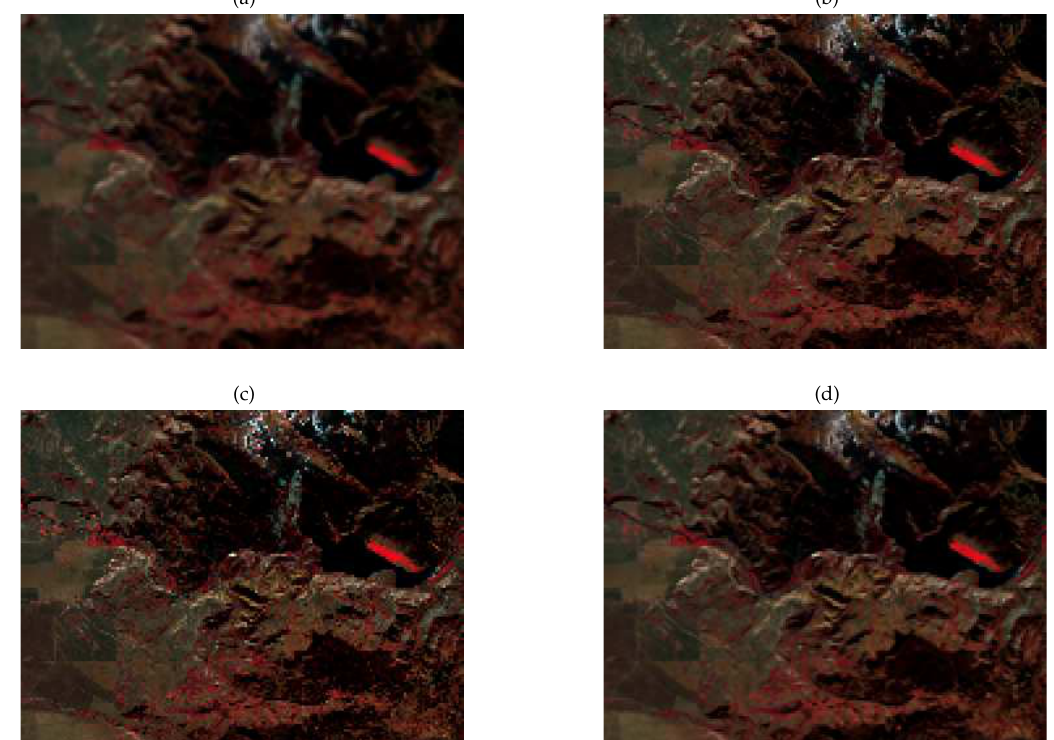
Figure 8. Simulated images filtered by: ( a ) Gaussian MTF with K m = 0.1; ( b ) Gaussian MTF with K m = 0.8; ( c ) All-pass filter; ( d ) 23-taps polynomial